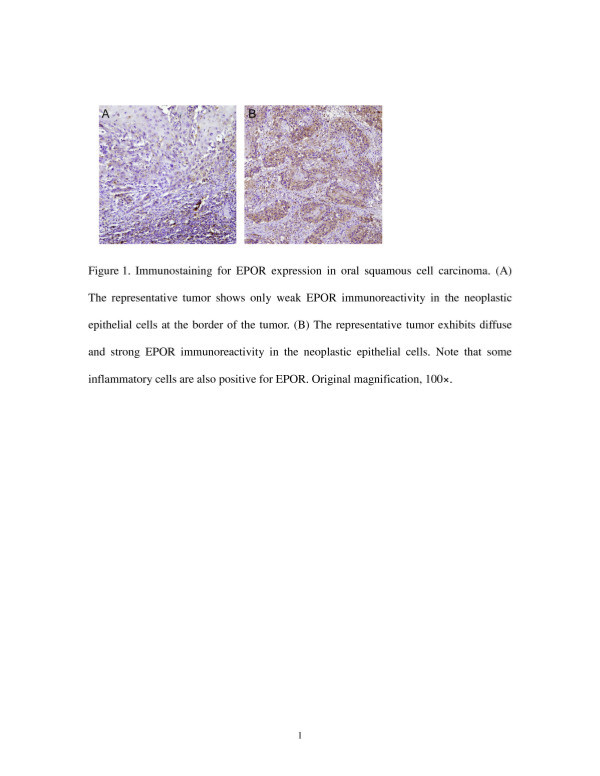
Immunostaining for EPOR expression in oral squamous cell carcinoma. (A) The representative tumor shows only weak EPOR immunoreactivity in the neoplastic epithelial cells at the border of the tumor. (B) The representative tumor exhibits diffuse and strong EPOR immunoreactivity in the neoplastic epithelial cells. Note that some inflammatory cells are also positive for EPOR. Original magnification, 100 × .